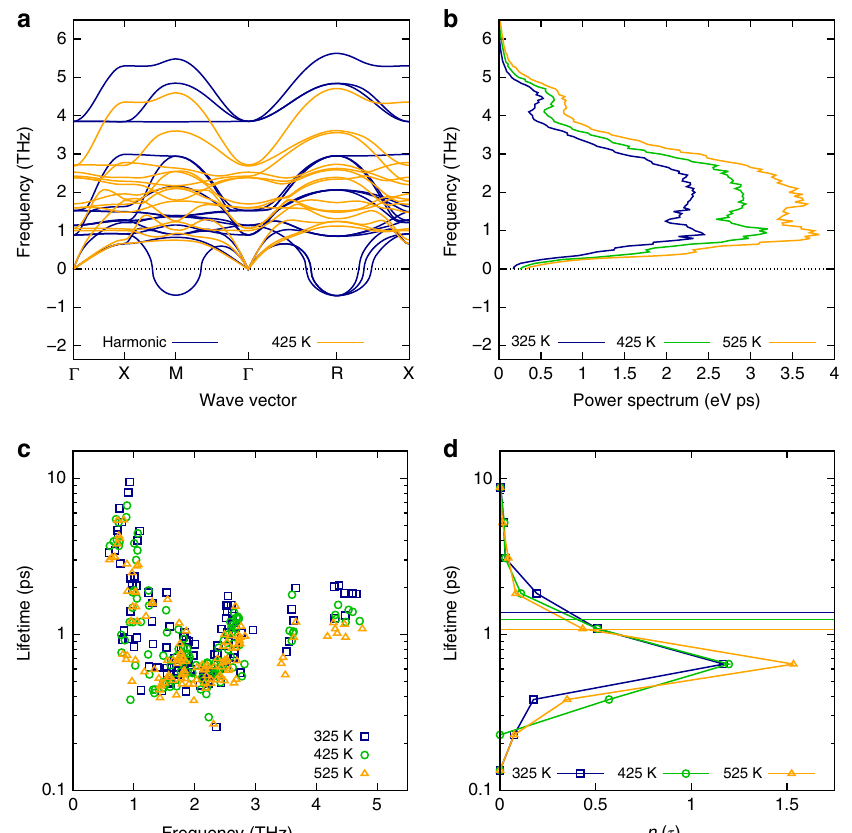
Fig. 2 Vibrational properties and anharmonicity in CsPbBr 3 . a Harmonic (blue) and fi nite-temperature renormalized phonon dispersion at T = 425 K (orange), as obtained from lattice dynamics calculations in the harmonic approximation and fully anharmonic MD, respectively. b Power spectrum of the velocity-autocorrelation function, as obtained from fully anharmonic MD, calculated at three temperatures. c Phonon lifetime as a function of the renormalized phonon frequency, shown at three temperatures. d Normalized histogram of the phonon lifetimes, τ , shown for each of the three considered temperatures; see Table 1 for further details. The normalization procedure is such that the integral over the range is 1. The vertical lines indicate the mean value of the distribution at each temperature, which are 1.38, 1.25, and 1.08 ps at 325, 425, and 525, fi nite temperature vibrational properties of CsPbBr fi nite temperature dispersion relation (see Fig. 2a), which is 3 obtained from a fully anharmonic treatment by means of DFT-based MD, expected. Figure 2b shows the power spectrum of the VACF, analyzing the VACF as described in the Methods section. The which represents the vibrational density of states (VDOS), at structural instabilities, seen as imaginary features in the 0 K three temperatures. Overall, while the vibrational features appear harmonic calculations of the phonon spectrum, vanish in the strongly broadened in the fi nite temperature spectra, one can still